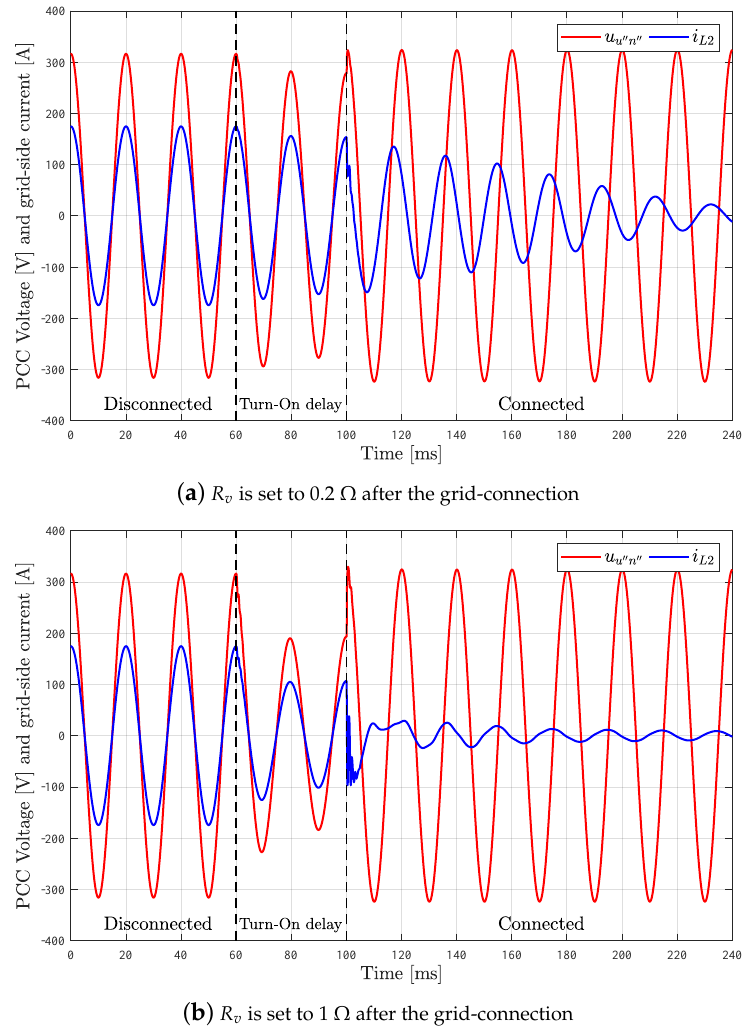
Figure 10. R v (0 Ω initially) effect during grid-disconnected to grid-connected transference at t = 50